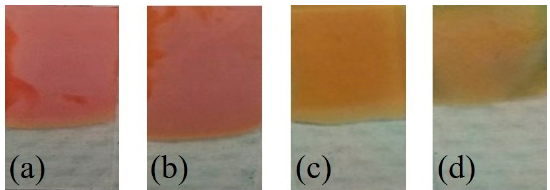
Figure 3. Photographs Cu 2 O samples prepared by electrodeposition in the presence of varying volumes of EDA in electrolytic bath from ( a ) 0.2 mL; ( b ) 0.4 mL; ( c ) 0.8 mL to ( d ) 1 mL.